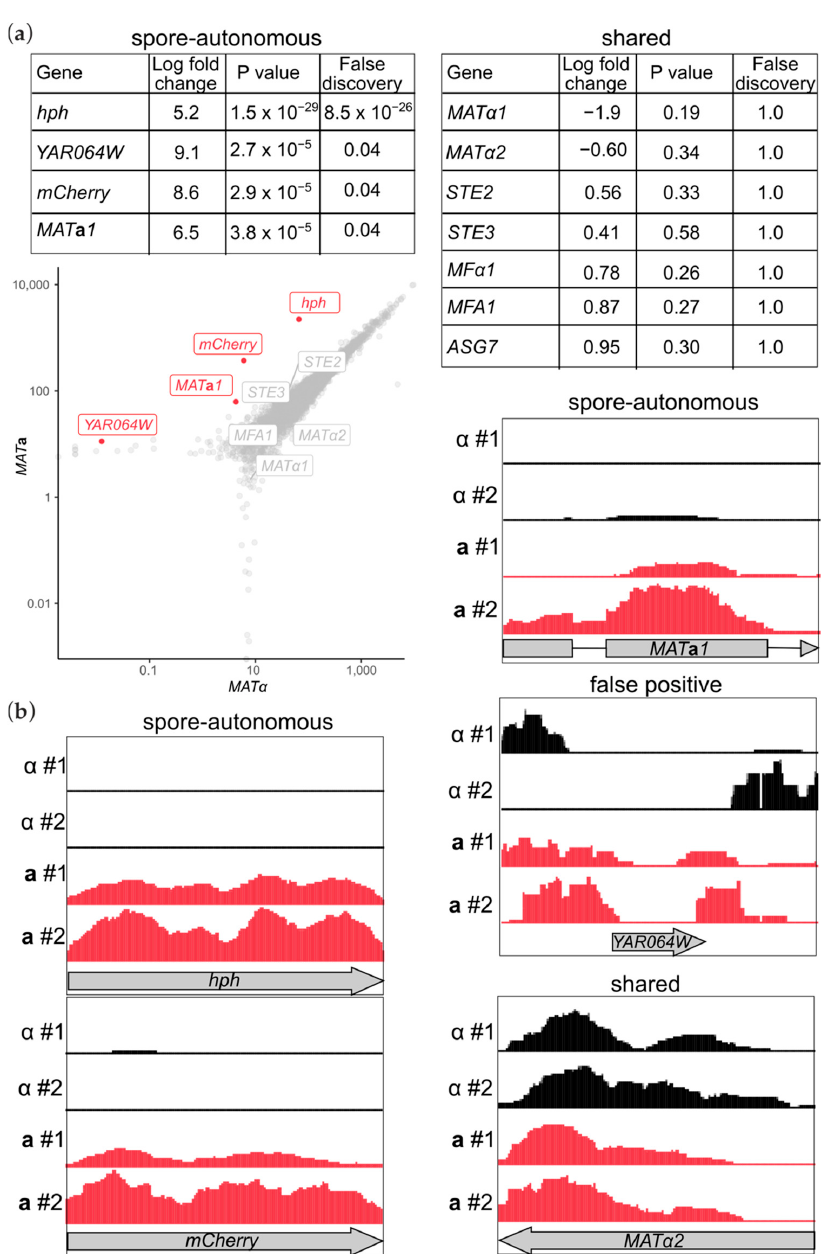
Figure 2. Inheritance of most “mating ‐ type ‐ specific” transcripts is independent of spore mating type. ( a ) RNA ‐ seq data were analyzed by edgeR to identify transcripts for which abundance differed significantly between spores of each mating type. Values for ten transcripts of interest are shown in the tables. All but the four in the “spore ‐ autonomous” table were shared approximately equally, according to a false ‐ discovery statistic of <0.05. The correlation plot below highlights those four in red. ( b ) RNA ‐ seq reads mapped onto the genome for the two biological replicates of the red (“ a ”) and not red (“ α ”) sorted spores. Shown are the four transcripts considered “spore ‐ autonomous” in ( a ) and Mat α 2 as an example of a “shared” transcript. Gene structures are illustrated below. For each transcript, the scale of the y axis is the same between all four samples. Our unbiased quantitative comparisons indicated that RNA ‐ seq reads mapping to YAR064W , a fragment of a pseudogene located in a largely silent subtelomeric region,